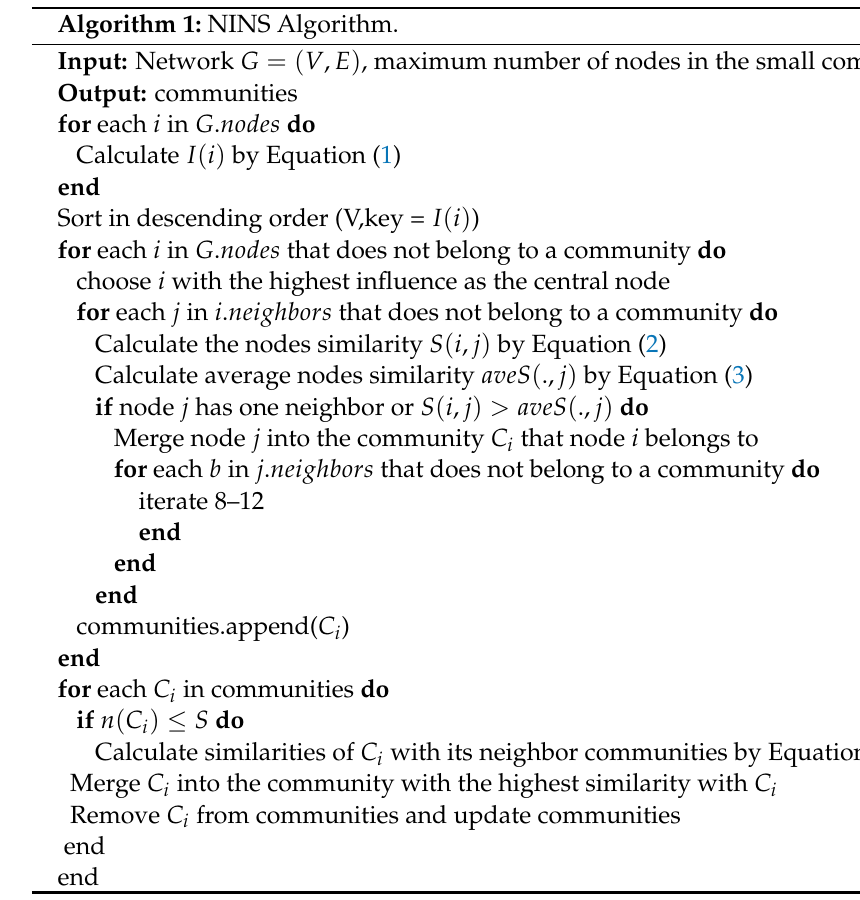
Algorithm 1: NINS Algorithm.